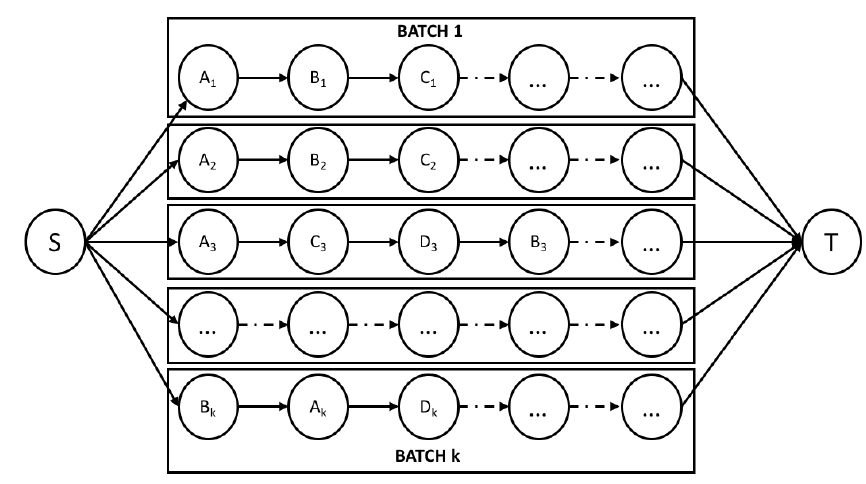
Figure 6. RCPSP model for re-manufacturing process of turbine